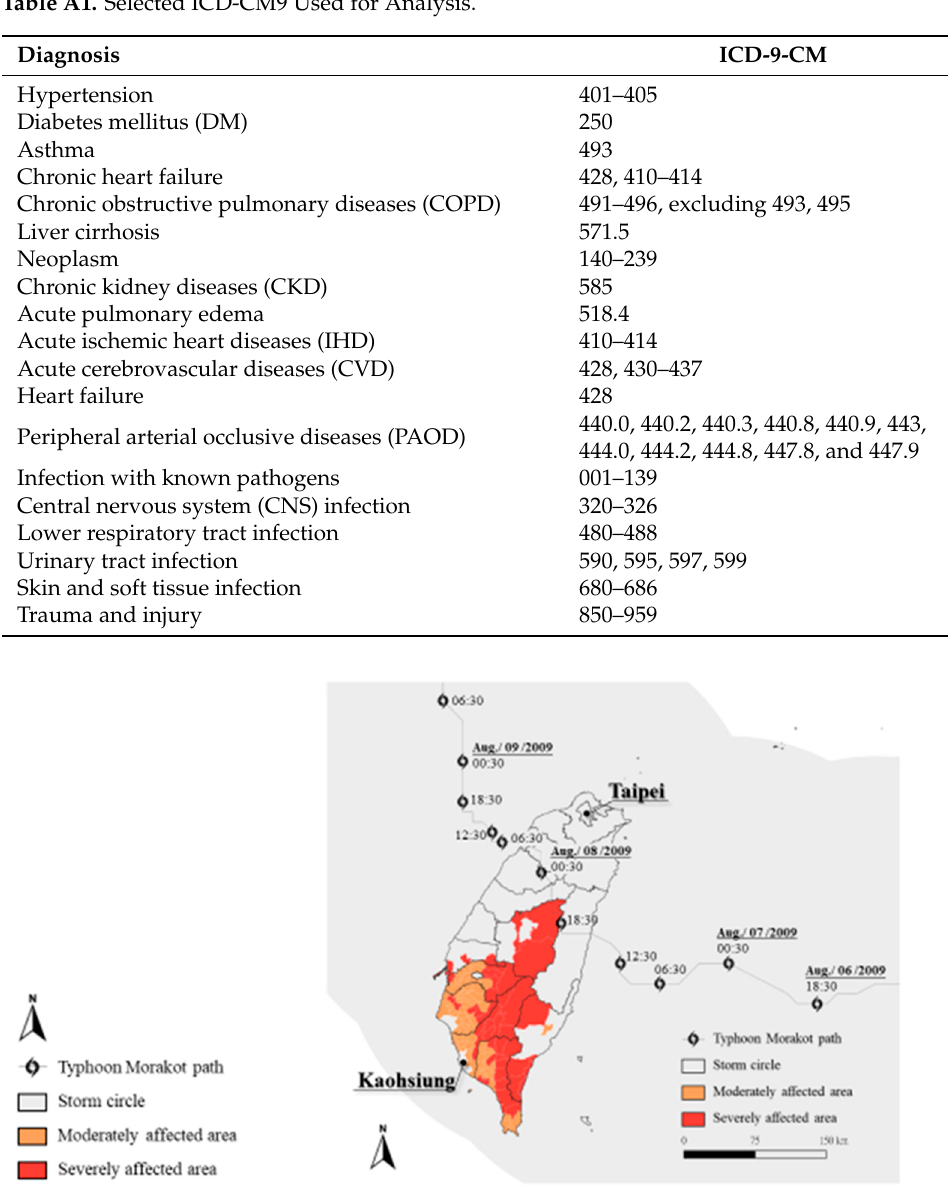
Figure A1. Affected areas and path of Typhoon Morakot.